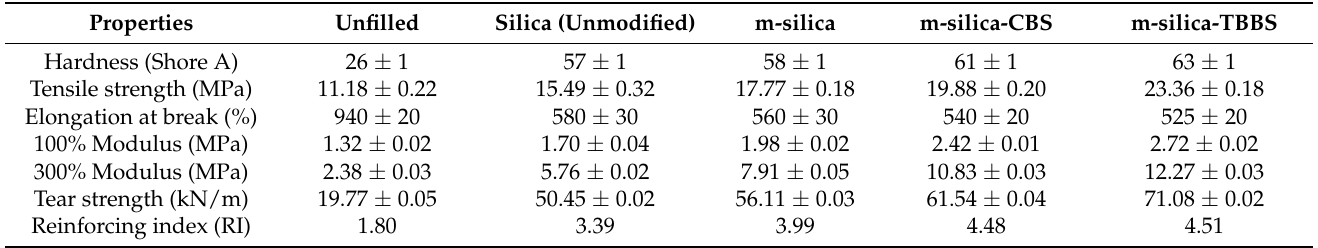
Table 4. The mechanical properties of unfilled natural rubber and natural rubber filled with